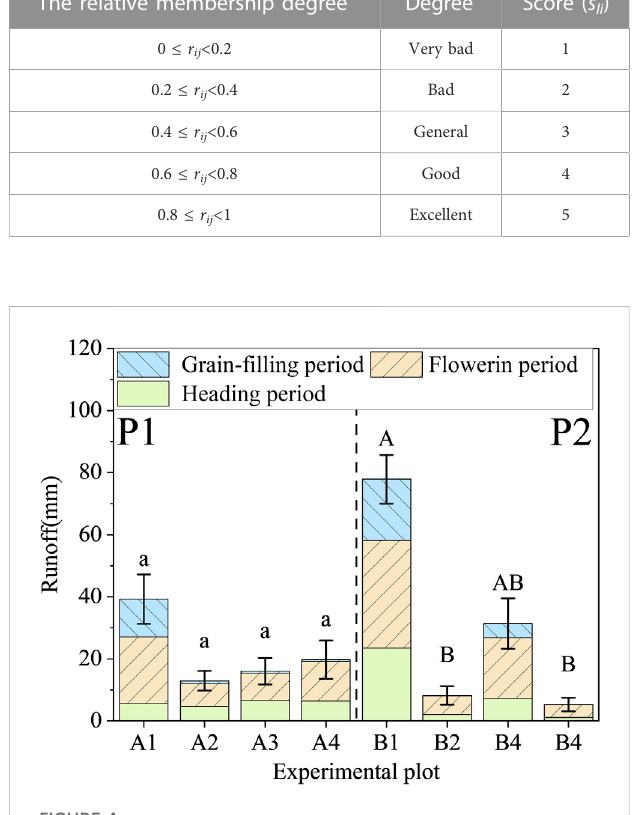
FIGURE 4 Observed runoff in different plots and growth periods under 100 mm/h(left)and50 mm/h(right)rainfallintensities.P1representsthe experimental plots under 100 mm/h rainfall intensity; P2 represents the experimental plots under 50 mm/h rainfall intensity, a – d and A – D indicatethesigni fi cantdifferencebetweenthedifferentgroupsat0.05in 100 and 50 mm/h,